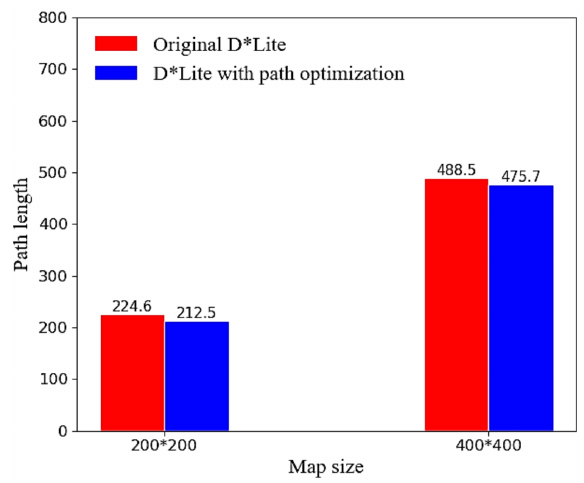
Figure 13. Comparison of path